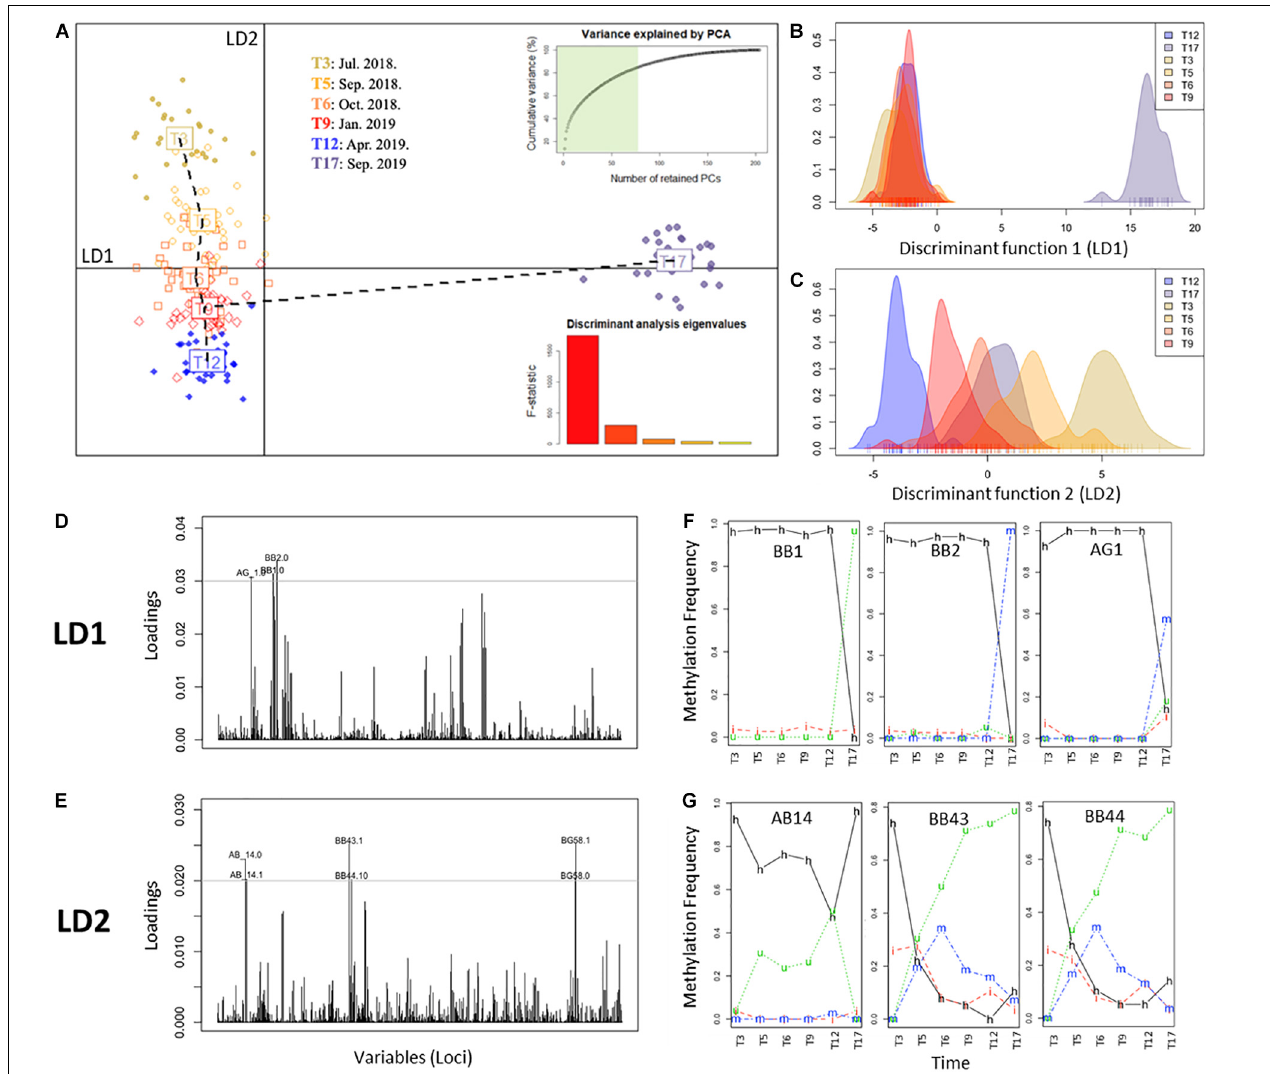
FIGURE 3 | Discriminant analysis of principal components (DAPC) of complete MSAP profiles representing the different groups (i.e., time points). (A) Scatterplot of monthly clusters resolved by DAPC. Barplot shows the significance of each of the five discriminant functions retained. In the upper-left corner the variance explained by the 77 PCs retained for the study. Horizontal line: x -axis, first discriminant function (LD1) and vertical line: y -axis, second discriminant function (LD2). (B,C) Density of methylation profiles of each A. cervicornis fragment against discriminant function 1 (LD1) and discriminant function 2 (LD2), respectively. (D,E) Loading plot of MSAP loci that most contributed to LD1 and LD2 respectively. (F,G) Temporal variation of the frequency of each methylation status of loci with high contribution to LD1 (BB1, BB2, AG1) and LD2 (AB14, BB43, BB44), respectively. Methylation status is indicated in the lines of the figure: h, hemimethylated; m, hypermethylated; i, internal cytosine methylation; u, non-methylated